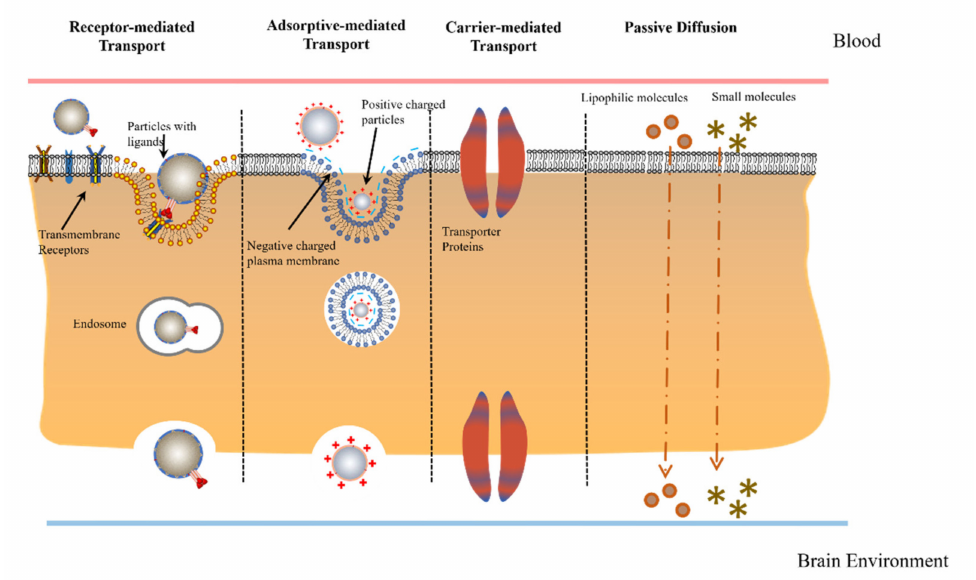
Figure 2. Physiological transport mechanisms crossing the